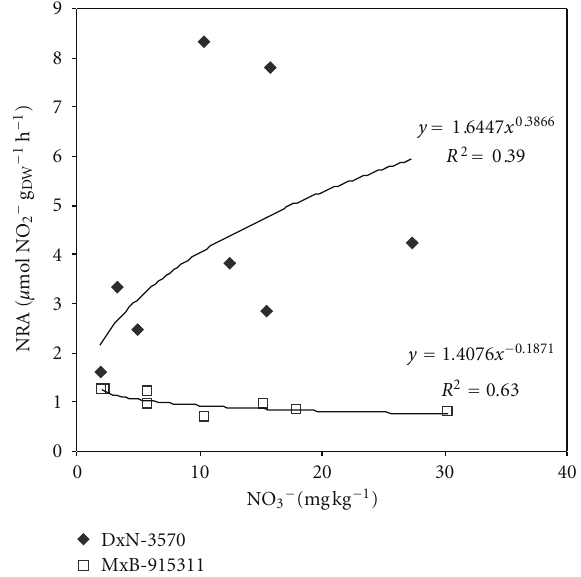
Figure 5: Relationship between NO 3 − concentration observed following a 24 day incubation period in riparian soils and nitrate reductase activity (NRA) for clone DxN-3570 ( P < 0 . 1) and MxB- 915311 ( P < 0 . 05). NRA values in this figure were obtained by averaging NRA values of the mid-July and late August